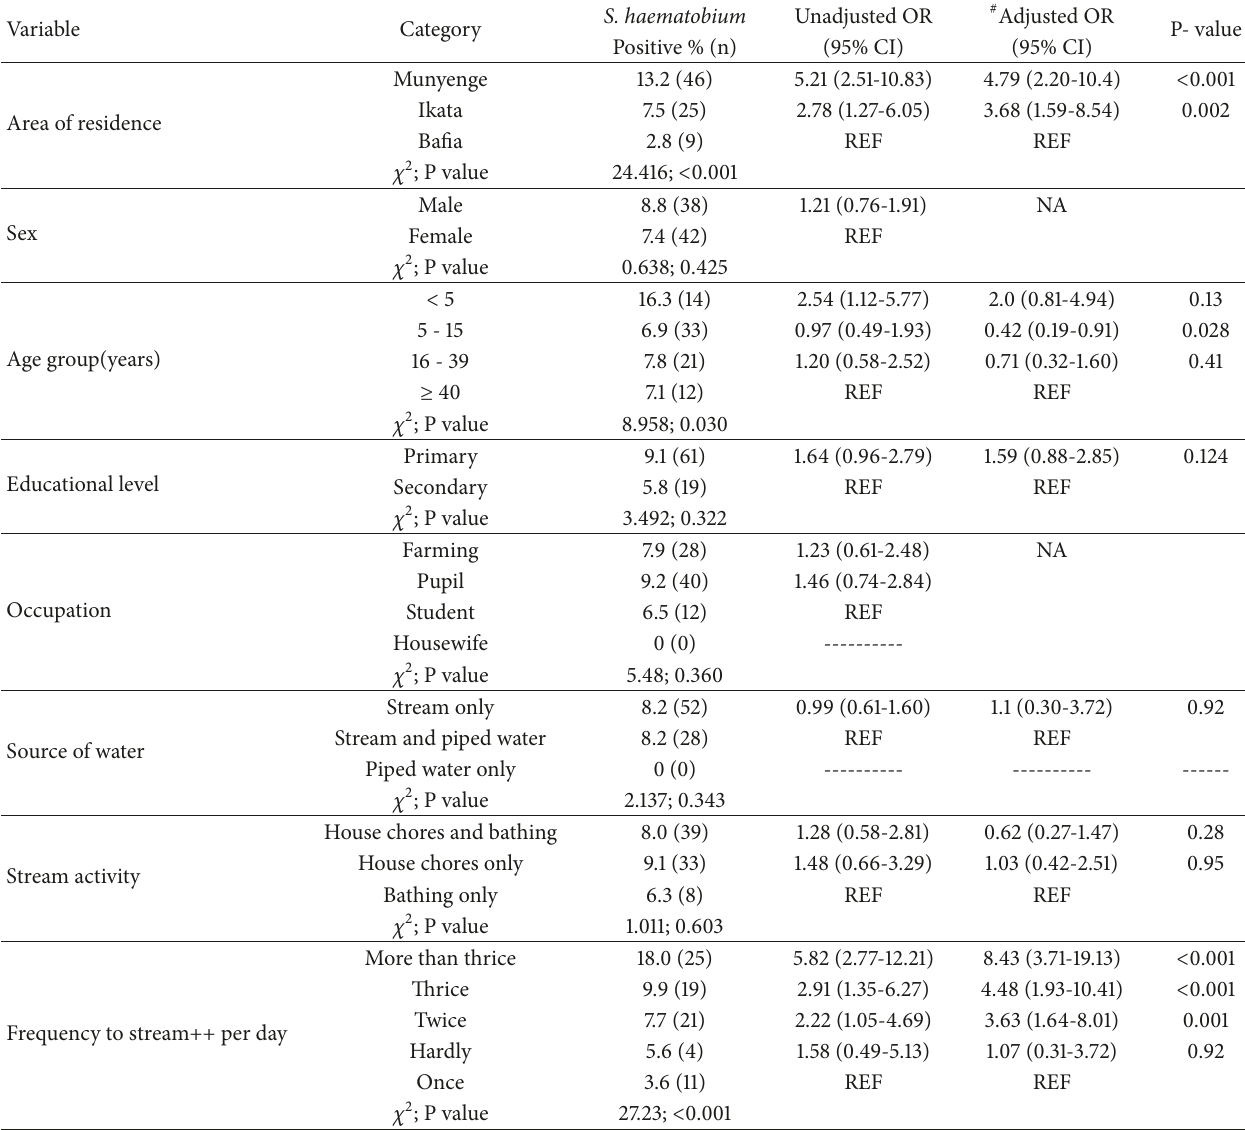
Table 2: Risk factors associated with S. haematobium egg excretion during the dry